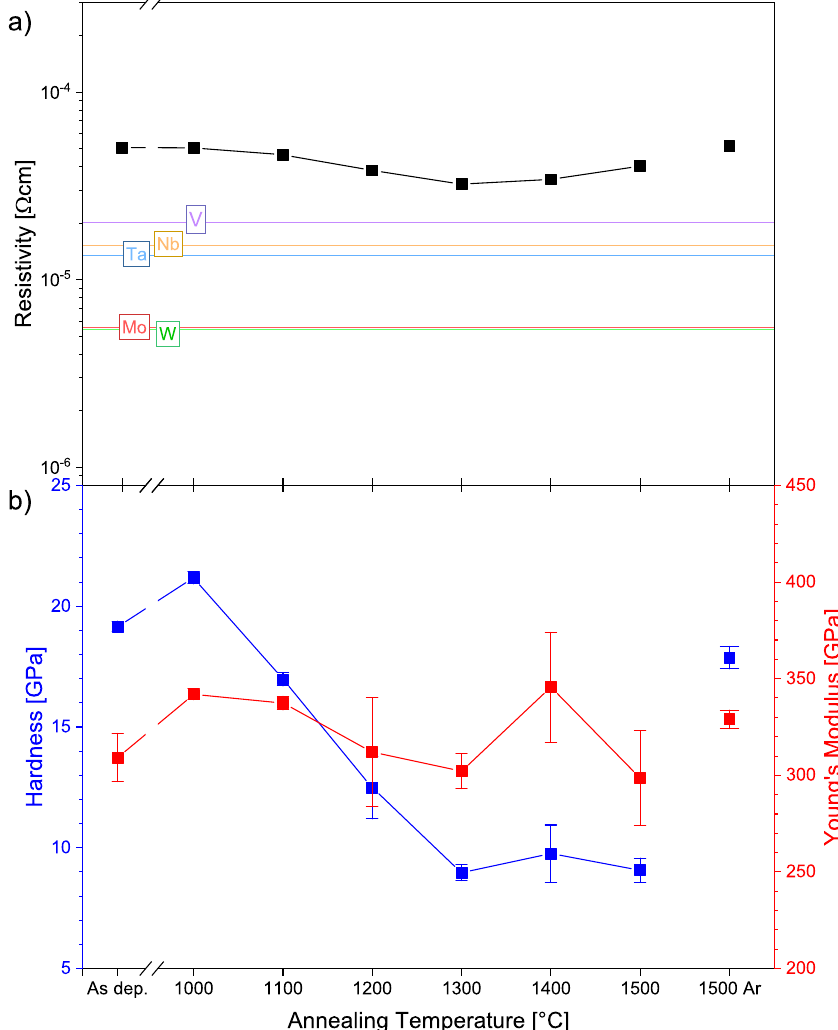
Figure 5. Electrical and mechanical properties of MoNbTaVW thin films on Al 2 O 3 substrates in as-deposited state and after annealing in vacuum and in Ar atmosphere: ( a ) Electrical resistivity with reference values for bulk metals [36–39] and ( b ) hardness and Young’s modulus